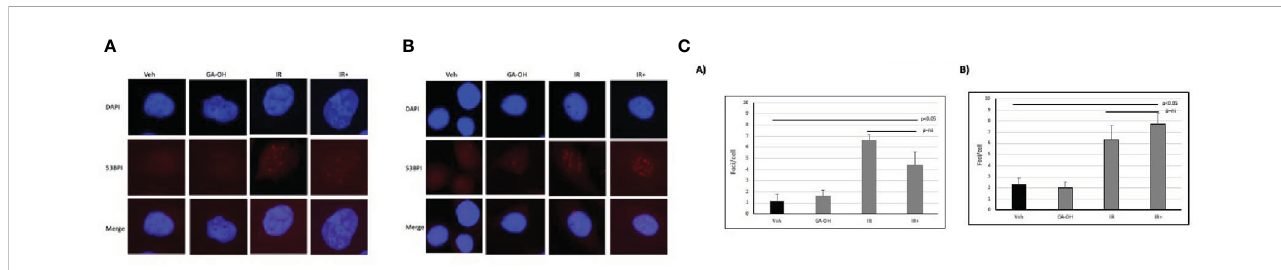
FIGURE 5 Effects of GA-OH on radiation-induced nuclear 53BP1 foci post-irradiation. HPV - (A) and HPV + (B) cells were stained with anti-53BP1 and counter- stained with DAPI following treatment with GA-OH and X-ray radiation. 53-BP1 foci represent residual DSBs and representative images of nuclei of HPV - cells and HPV + cells after treatment are shown in (A, B) . (C) shows quanti fi cation of 53BP1 foci. Blue represents DAPI counter-stain and red 53BP1 foci.